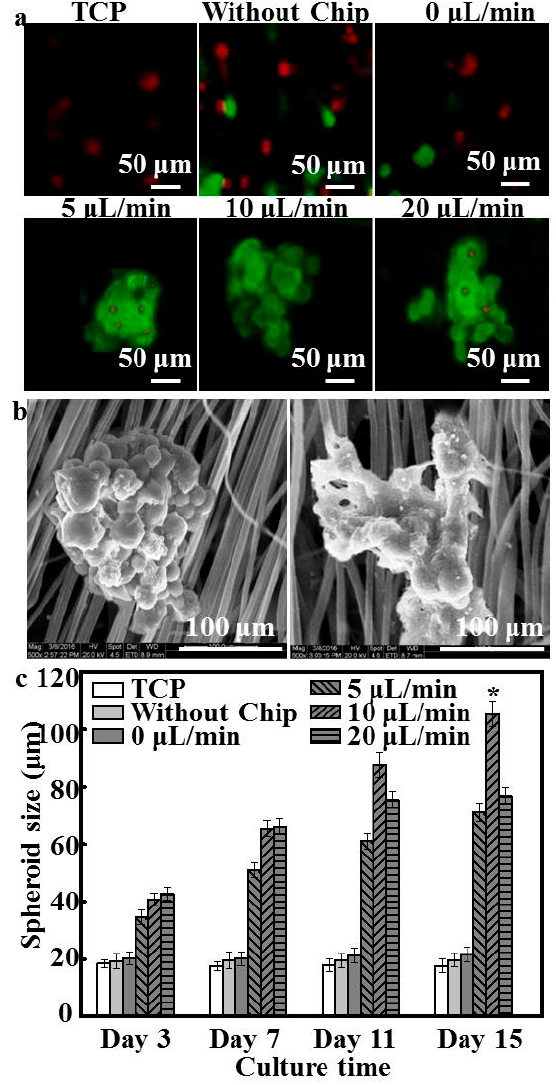
Figure 4. ( a ) CLSM images of spheroids formed on different substrates after 15 days in culture; ( b ) SEM images of hepatocytes under the flow rate of 10 and 20 µ L/min after 15 days of incubation; ( c ) size of hepatocyte spheroids after 15 days of culture on different substrates ( n = 5); * p < 0.05.